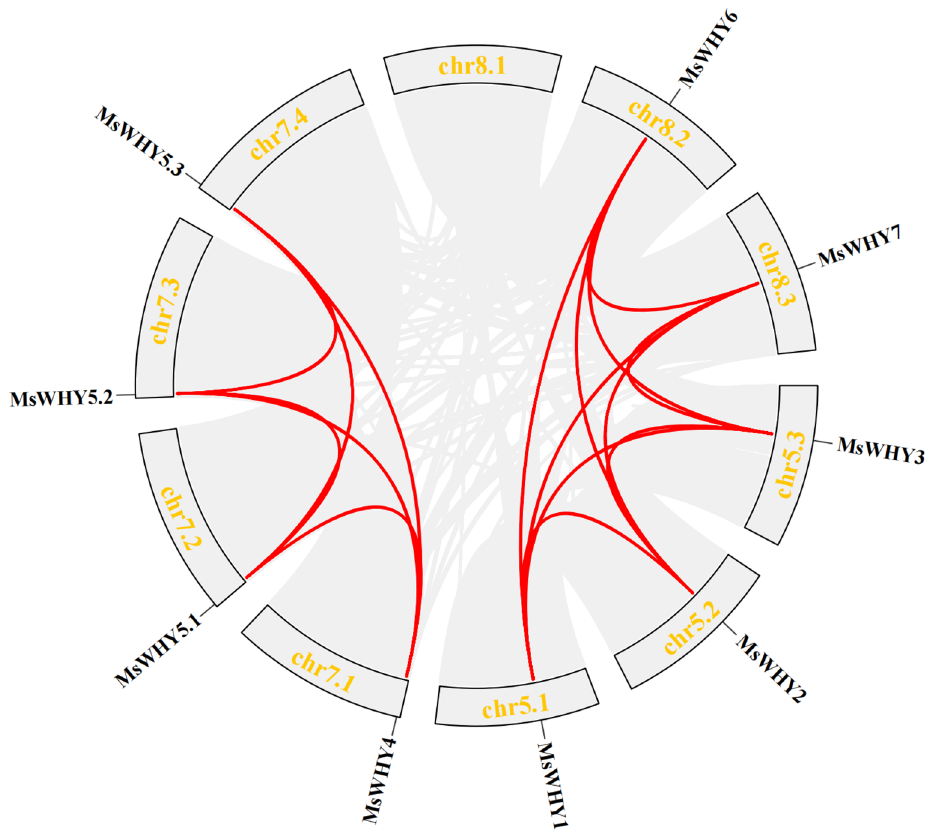
Figure 3. Syntenic relationship of MsWHYs . The number on the fragments represents the positions on the corresponding chromosomes. The MsWHYs involved in segmental duplications in the MsWHY gene family are mapped to their respective locations of the alfalfa genome in the circular diagram. The red lines represent the segmental duplication pairs between the MsWHYs and the gray lines represent the segmental duplication pairs in the whole alfalfa genome.